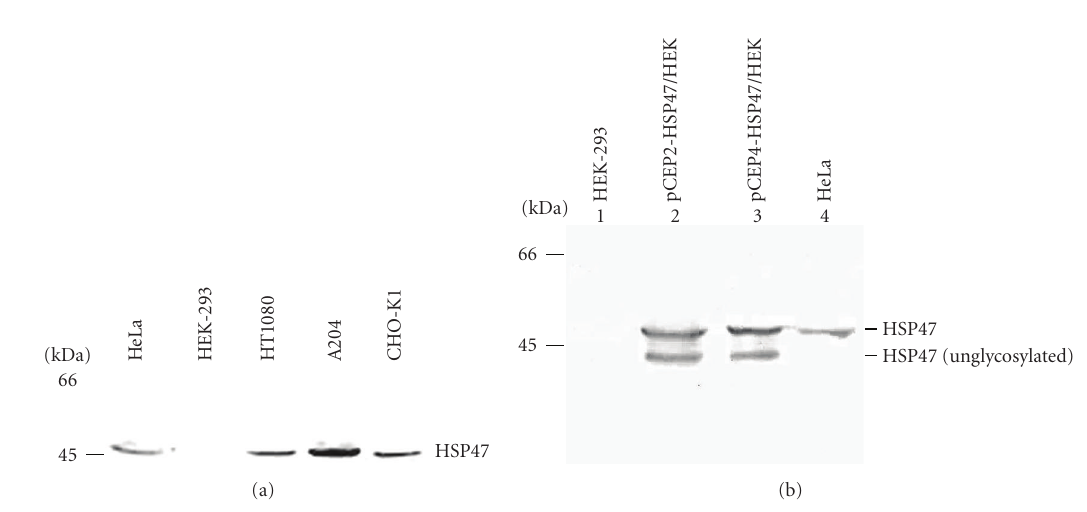
Figure 4: Characterization of the recombinant procollagen V molecular forms produced in HEK-293 transfected cells. (a) Western blot analysis of the supernatant of transfected cell media dialysed against Tris-HCl 50 mM, pH 8.6, digested (lane 2) or not (lane1) with pepsin. Transfected cell media were centrifuged and the supernatant was applied to a DEAE column. (b) Separation of the di ff erent collagen V molecular species from transfected cell media by cation exchange chromatography. Western blot analysis of the loaded sample (lane 1) and of the fractions eluted at 0.16M (lane 2), 0.24 M (lane 3), 0.37 M (lane 4), and 0.42 M (lane 5) NaCl. Membranes were double probed with mAb 18G5 followed by alkaline phosphatase antimouse secondary antibodies and with pAb CollV followed by peroxydase antirabbit secondary antibodies. Left, molecular mass standards expressed in kDa.